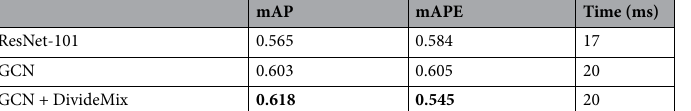
Table 2. Comparison of mean average precision (mAP—higher is better) and mean absolute percentage error (mAPE—lower is better) between the ResNet-101, the GCN, and the GCN architecture with noise-robust training procedure.